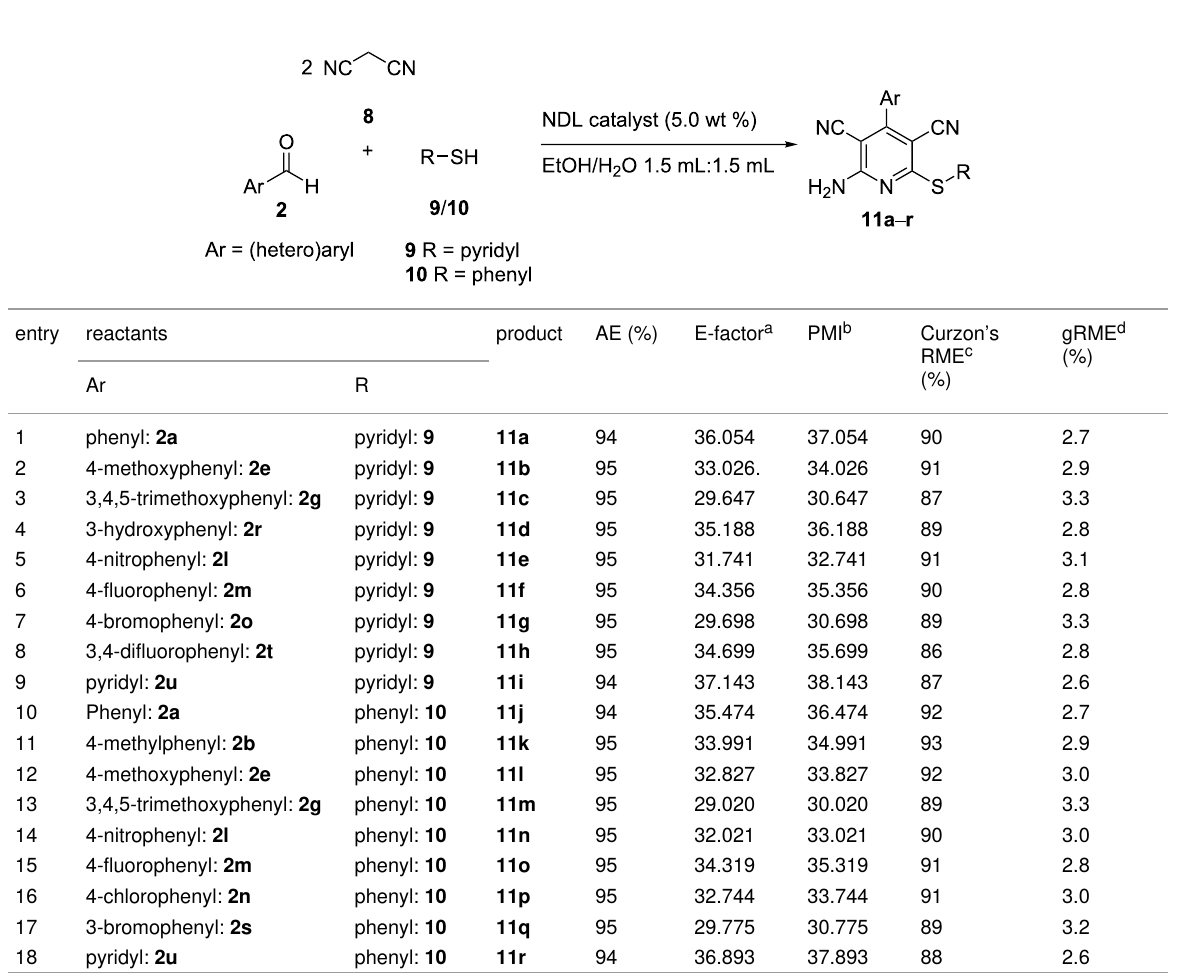
Table 10: Green chemistry metrics for the synthesis of 2-amino-4-(hetero)aryl-3,5-dicarbonitrile-6-sulfanylpyridines 11